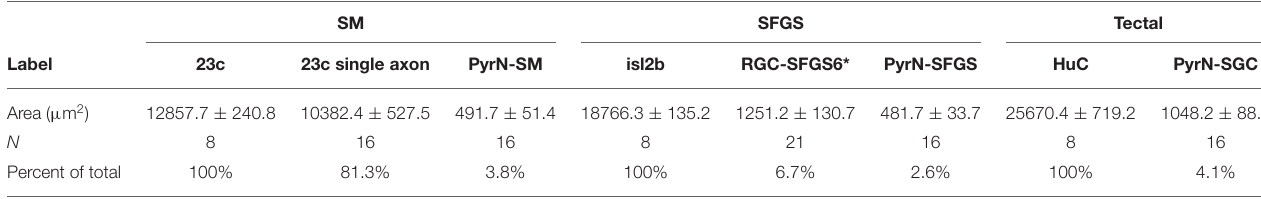
TABLE 1 | Cell type-specific morphological analysis of arbor area in tectal